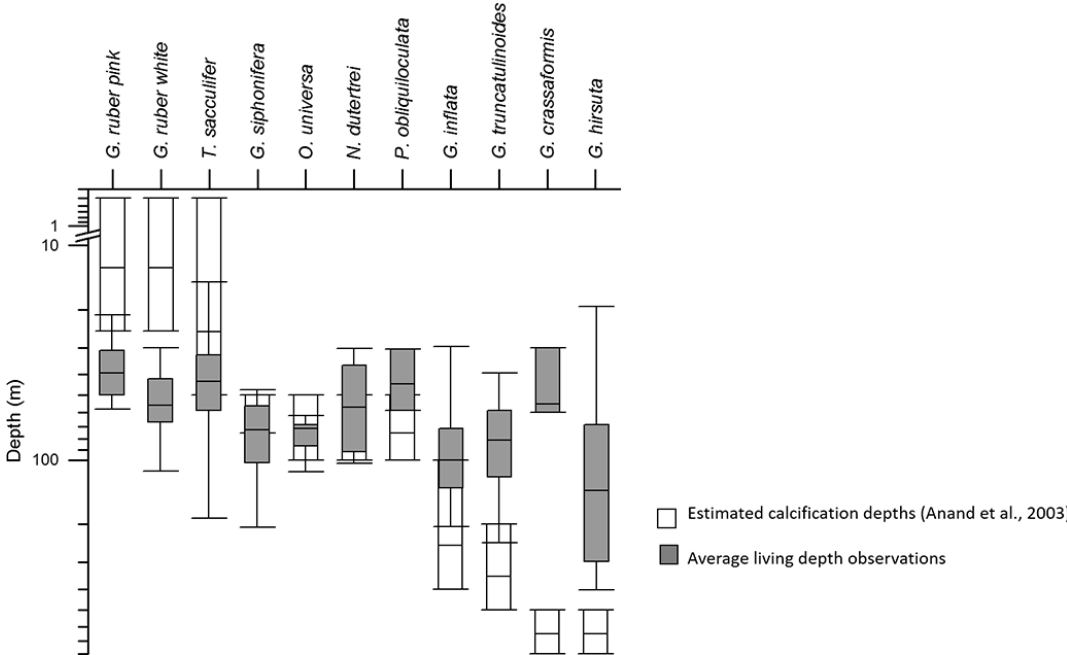
Figure 11. Estimated calcification depth based on δ 18 O values of species of planktonic foraminifera from the Sargasso Sea and the calcite in equilibrium with seawater (white; Anand et al., 2003) and the average living depth based on observations of living specimens from vertically resolved plankton tows from the eastern North Atlantic (dark gray, Fig.